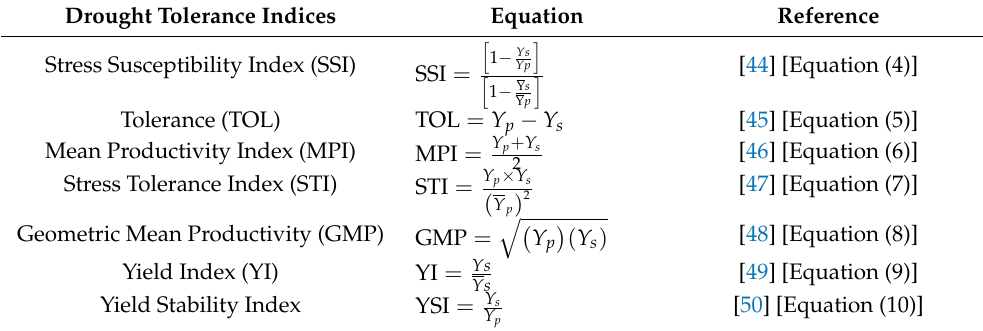
Table 6. Drought tolerance indices used to evaluate Bambara groundnut genotypes for drought tolerance. Drought Tolerance